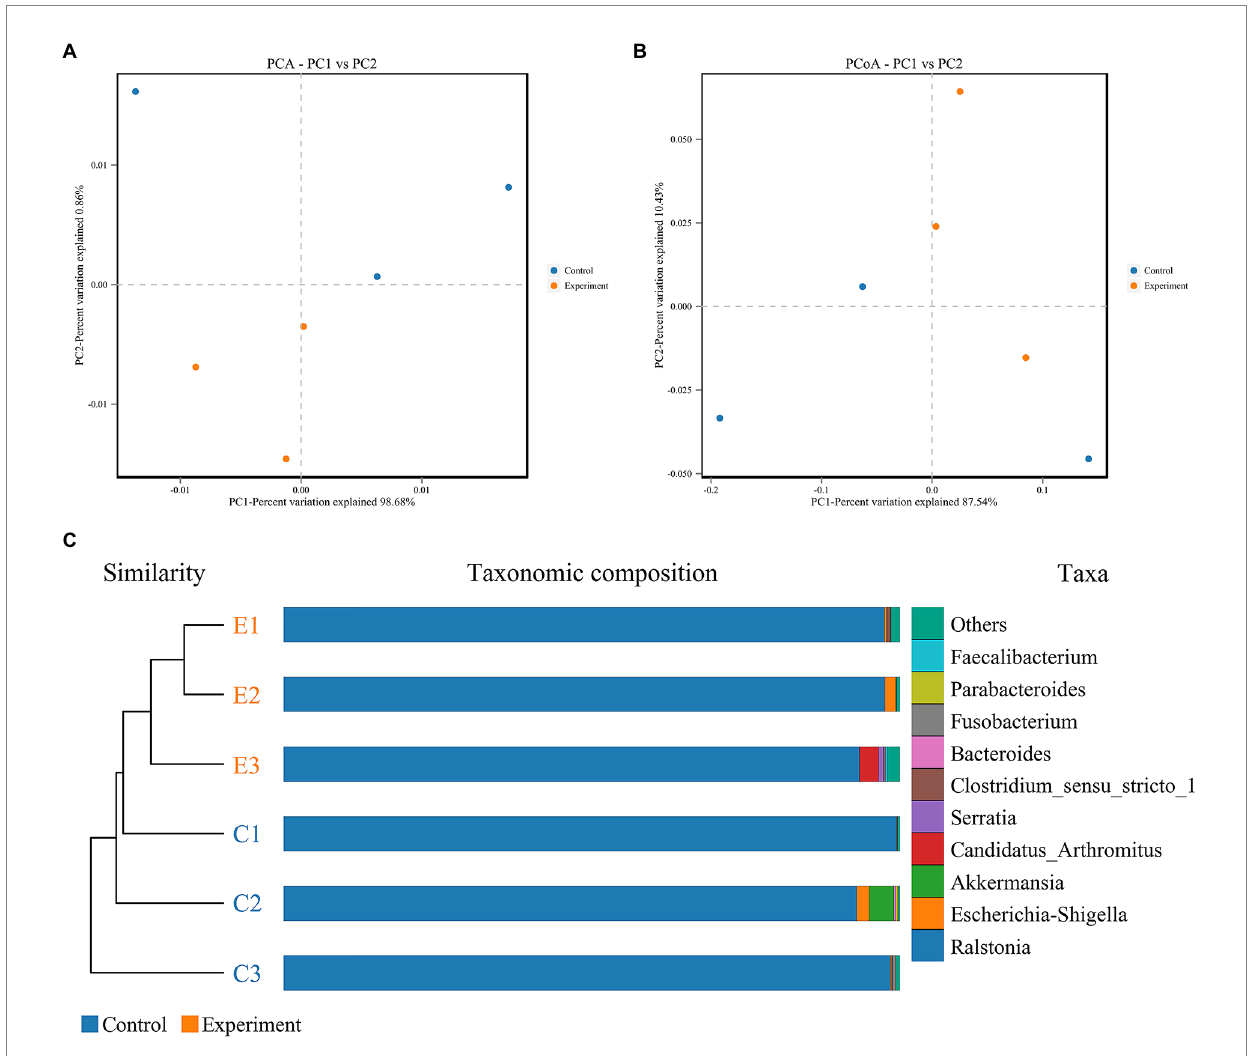
FIGURE 4 Beta diversity analysis of intestinal microbes of Chinese sea bass in the Aeromonas hydrophila infection and control groups. (A) Principal component analysis (PCA) of intestinal microbes. (B) Principal coordinates analysis (PCoA) of intestinal microbes. (C) UPGMA cluster tree analysis of intestinal microbes. The top right figure represents the top 10 species according to the species abundance in the table. Other species are classified as “Others,” and the species not annotated are